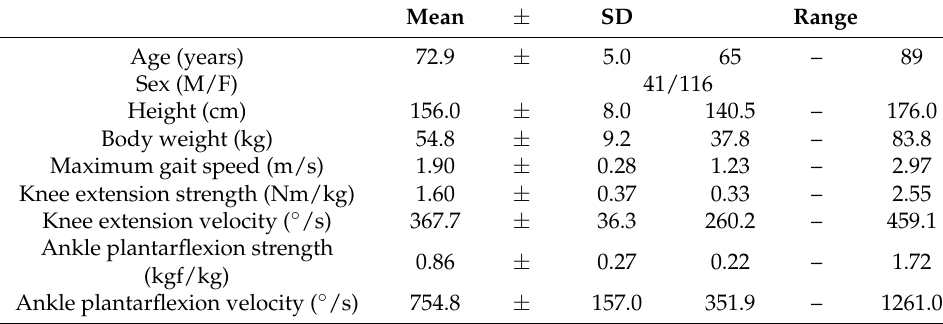
Table 2. Correlation between gait speed and lower limb